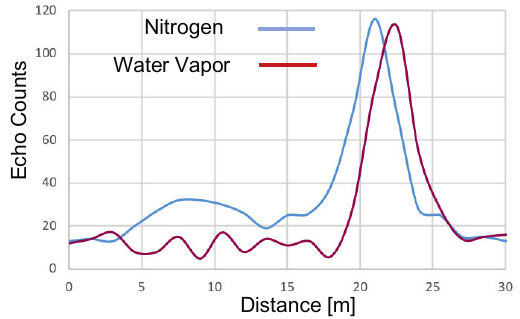
Fig.5 Interaction between sea surface atmosphere and water echoes at 17:59:57 on 28 th Dec.